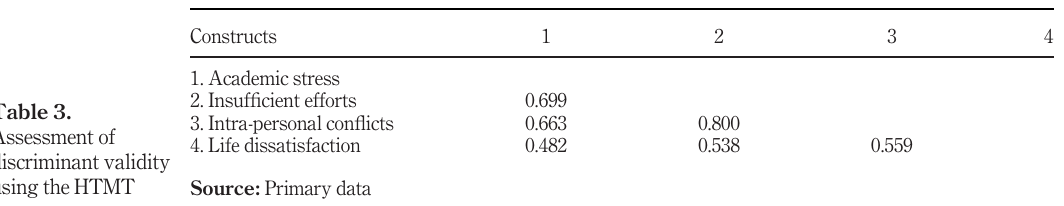
Table 3. Assessment of